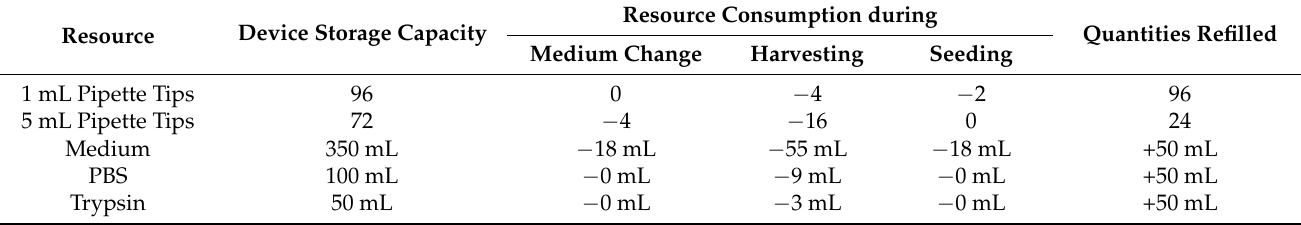
Table 1. Resource capacity of the liquid handling unit (LHU) in the StemCellDiscovery, consumption through the different process steps by processes and quantities refilled during the restocking process. The restocking process thereby only refills one resource type at a time. To refill multiple resources, the restocking process has to be triggered multiple times. Resource